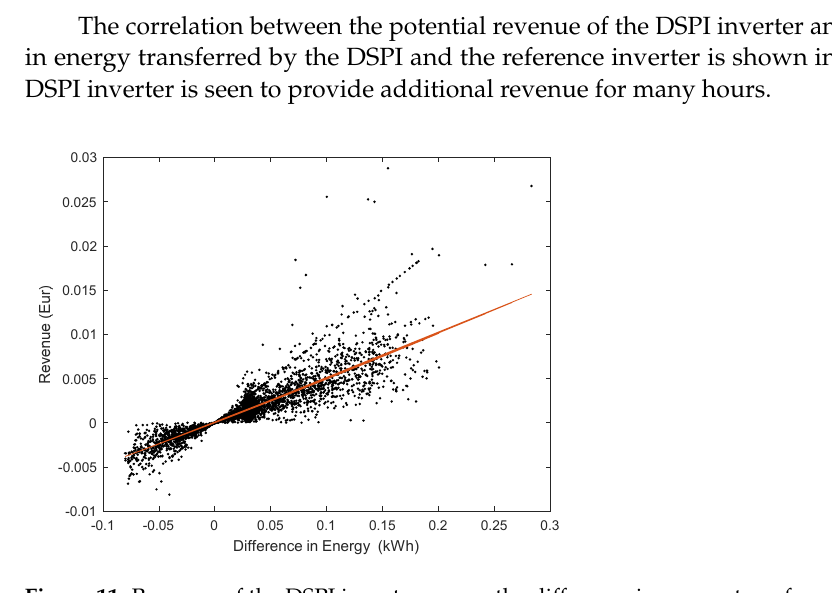
Figure 10. NordPool spot market prices: ( a ) annual profile (the red line shows the average price value); ( b ) day profile.